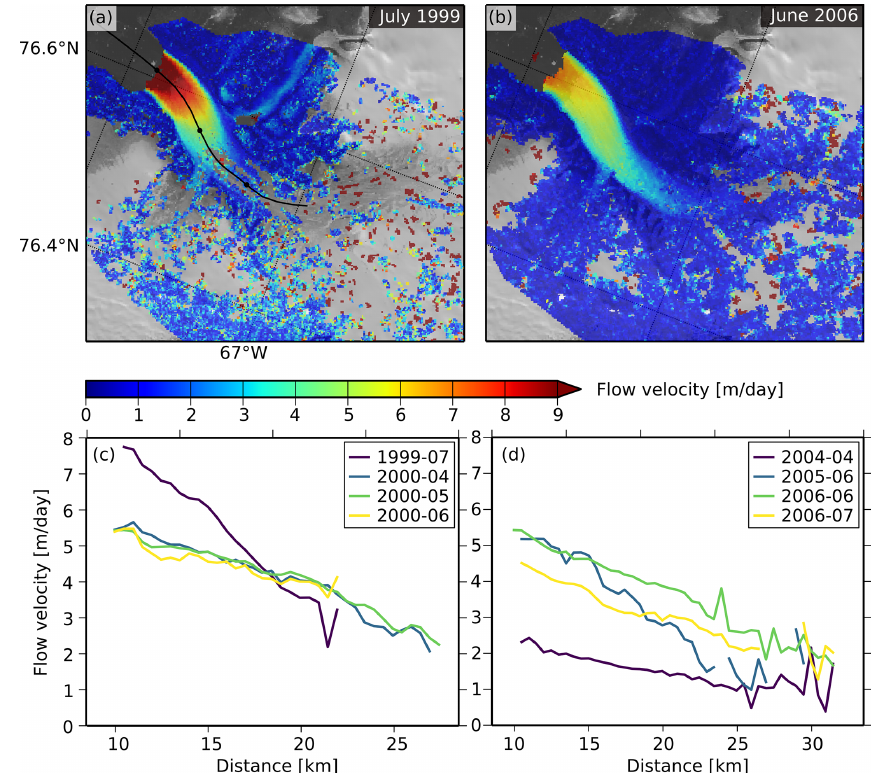
Figure 5. Exemplary velocity fields (a, b) and velocity profiles (c, d) for the surges 1999/2000 and 2005/2006. The profile location is shown as a black line in (a) , with black circles every 10km along the profile. The starting point of this line is the glacier front position of 1916. The background image in (a, b) is a Landsat 8 scene (USGS,